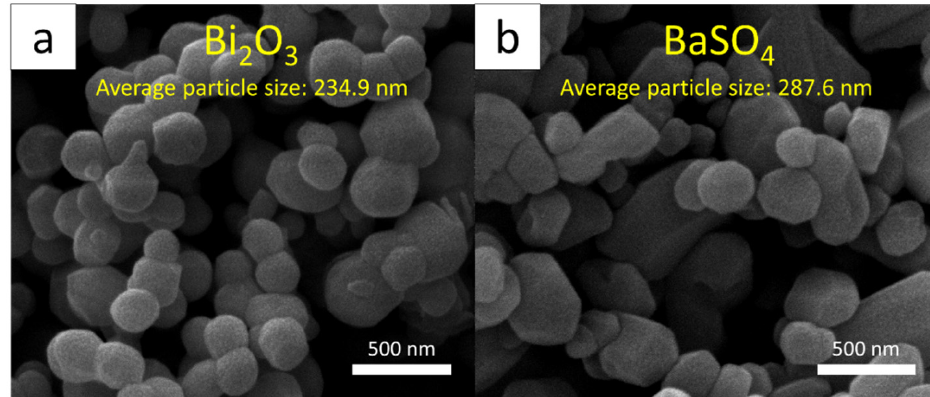
Figure 1. SEM images of ( a ) nano-Bi 2 O 3 and ( b ) nano-BaSO 4 (60,000×